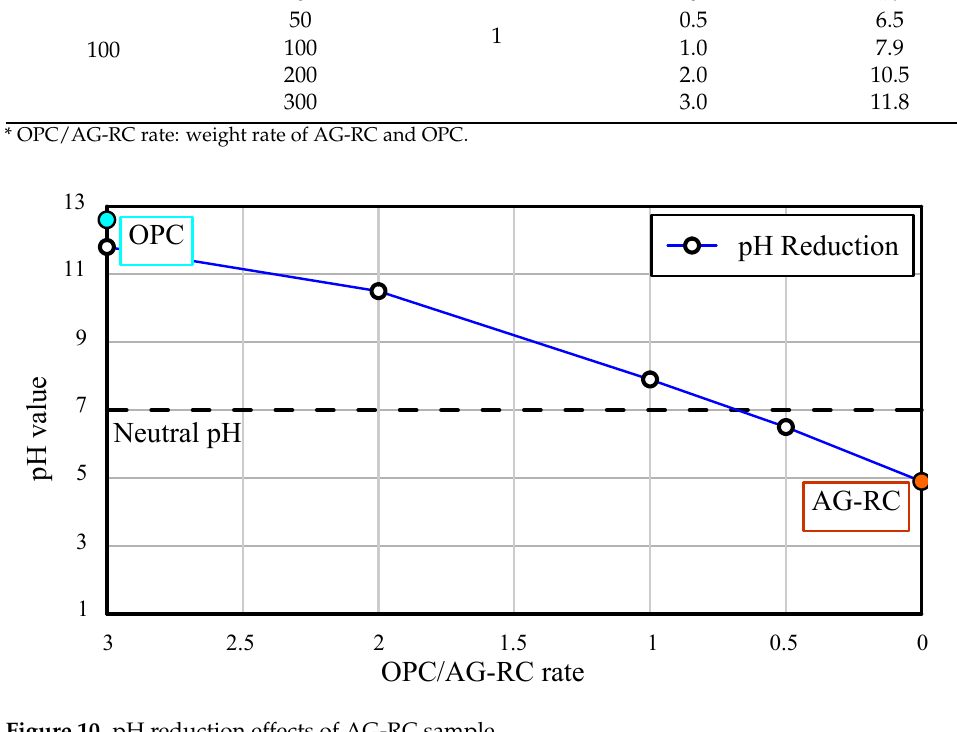
Figure 10. pH reduction effects of AG-RC sample. Table 5. pH reduction test results.